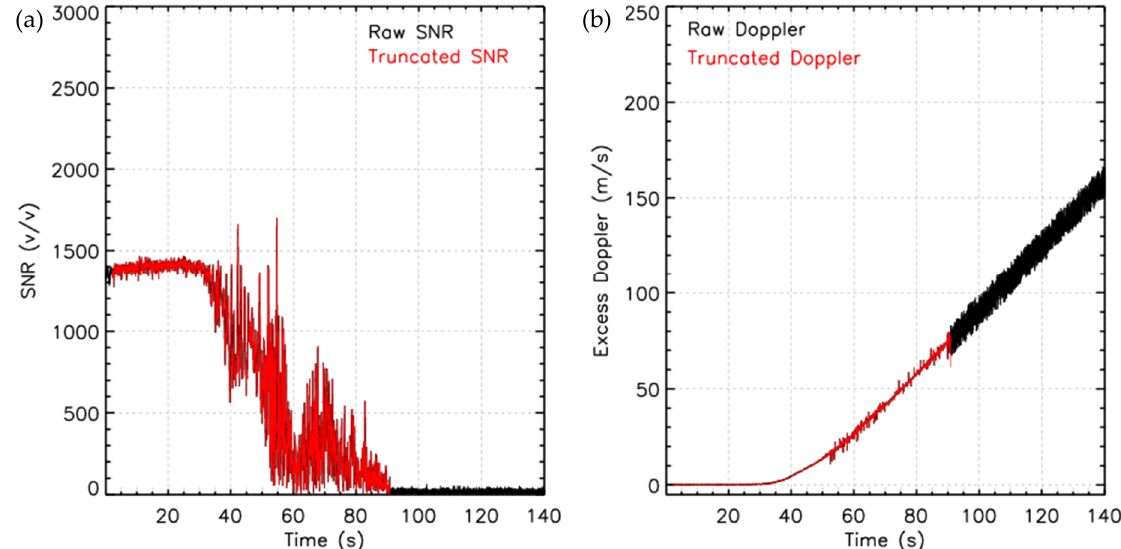
Figure 5. An example of the signal truncation scheme used in NOAA STAR processing, ( a ) SNR of the original/truncated signal in black/red and ( b ) excess Doppler of the original/truncated signal in black/red.